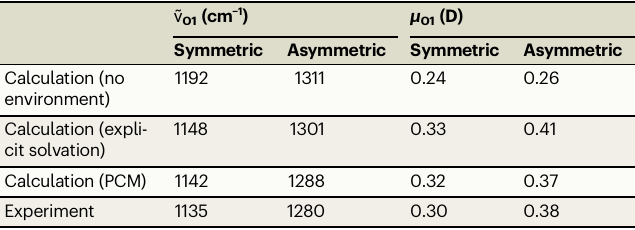
Table 1 | Parameters characterizing the resonances of DMSO